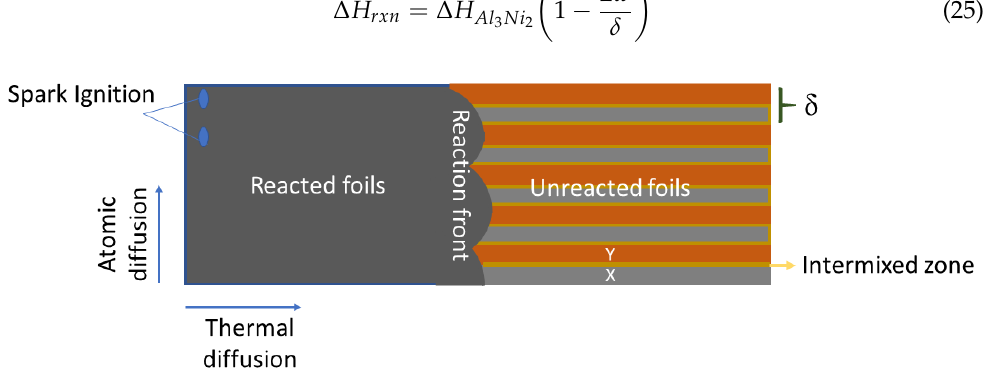
Figure 8. Schematic of the reactive multilayers of x and y metals.